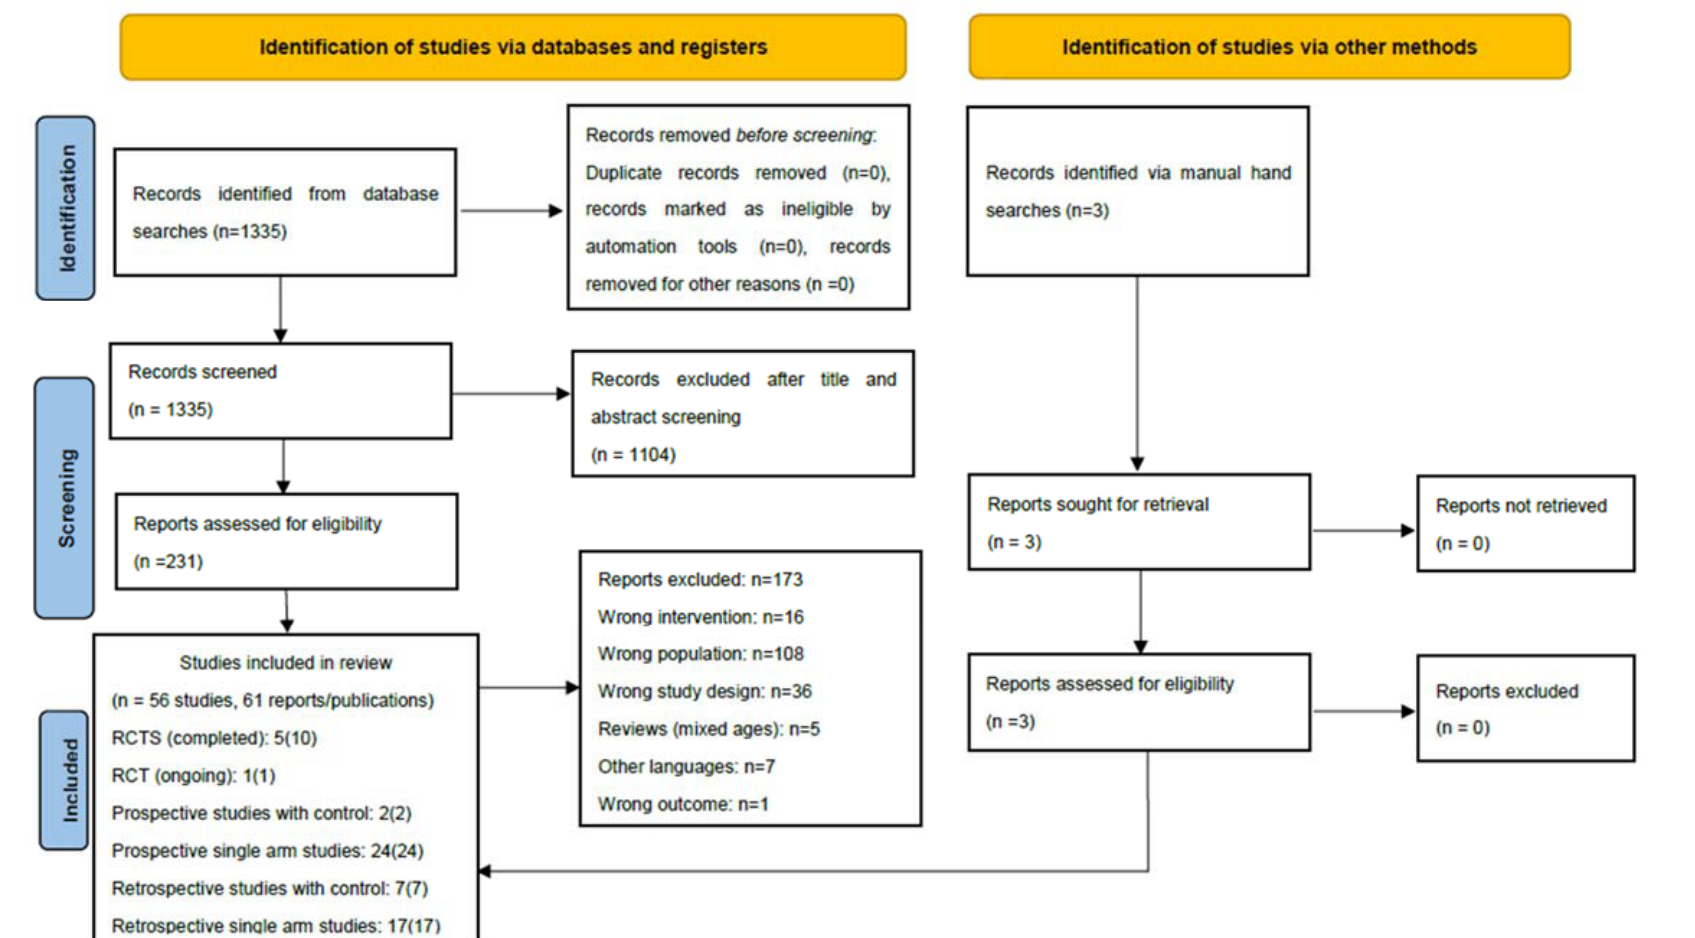
Figure 1. Results of the bibliographic literature searches and study 198 selection (PRISMA 2020 flow diagram). RCT: randomized controlled trial. From: [42] For more information, visit: